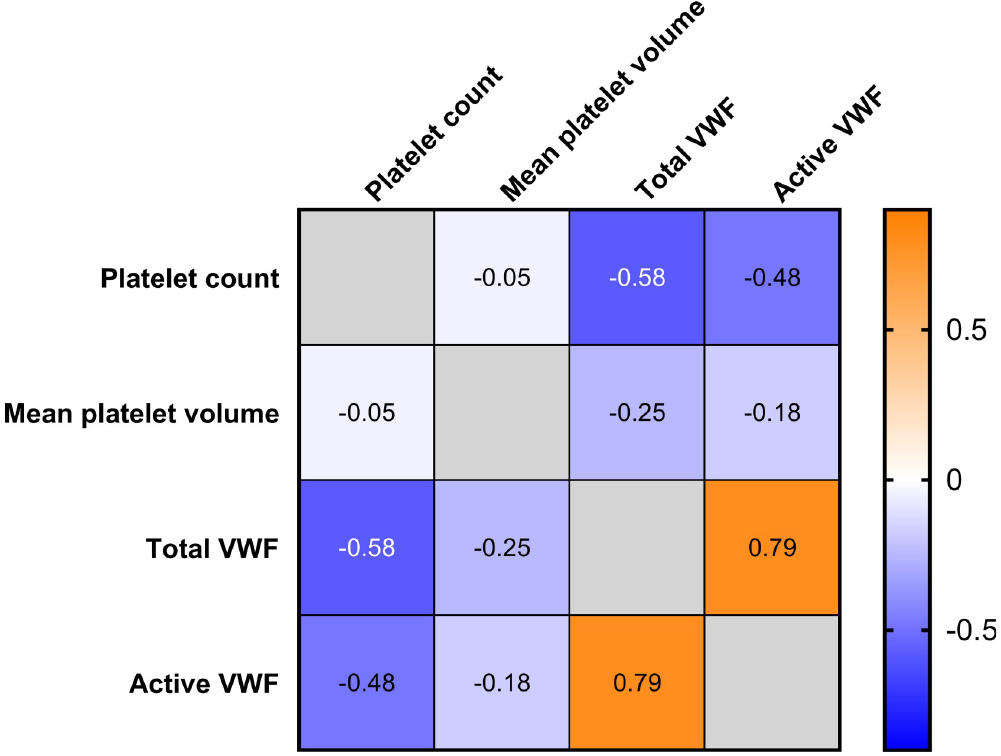
Fig 4. Correlation of platelet number and coagulation parameters. Correlation analysis shows that the platelet count is significantly associated with the total VWF level (p < 0.001) and the active VWF level (P = 0.001). The mean platelet volume shows a tendency towards a correlation with active VWF levels, but this effect is statistically insignificant. (p = 0.093). Total and active VWF show a strong mutual association (p <